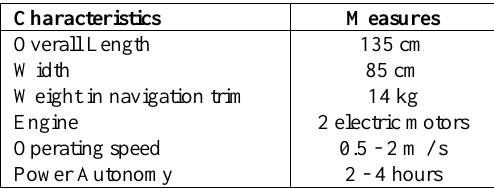
Table 1. Characteristics of